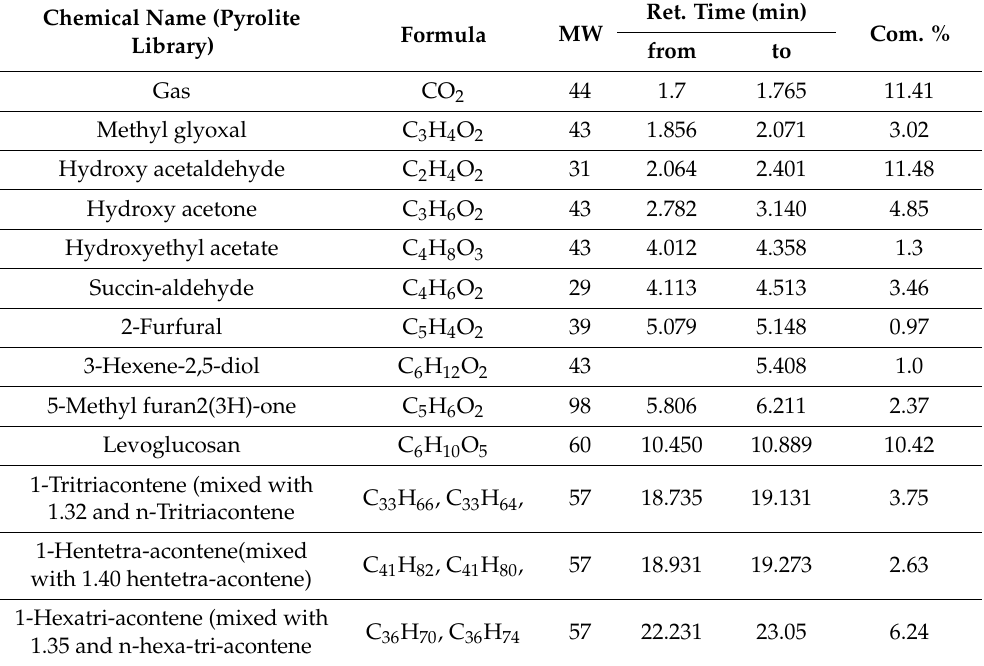
Table 4. List of pyrolite compounds from Py-GC-MS analysis of HC produced at 220 ◦